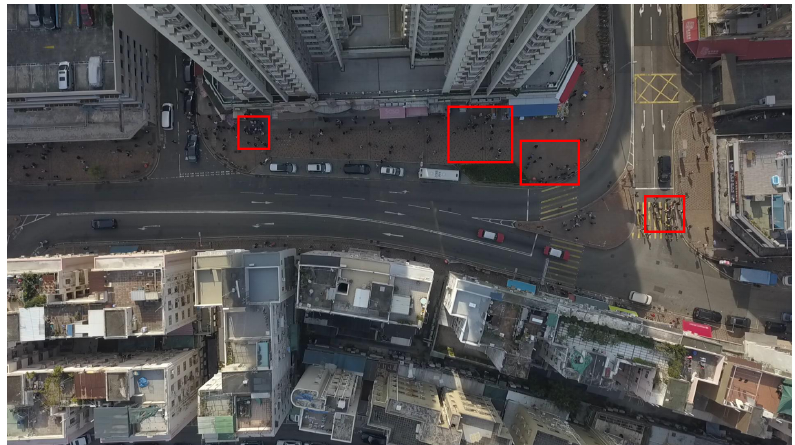
Figure 4. Example application of ML algorithm pinpointing potential crowded